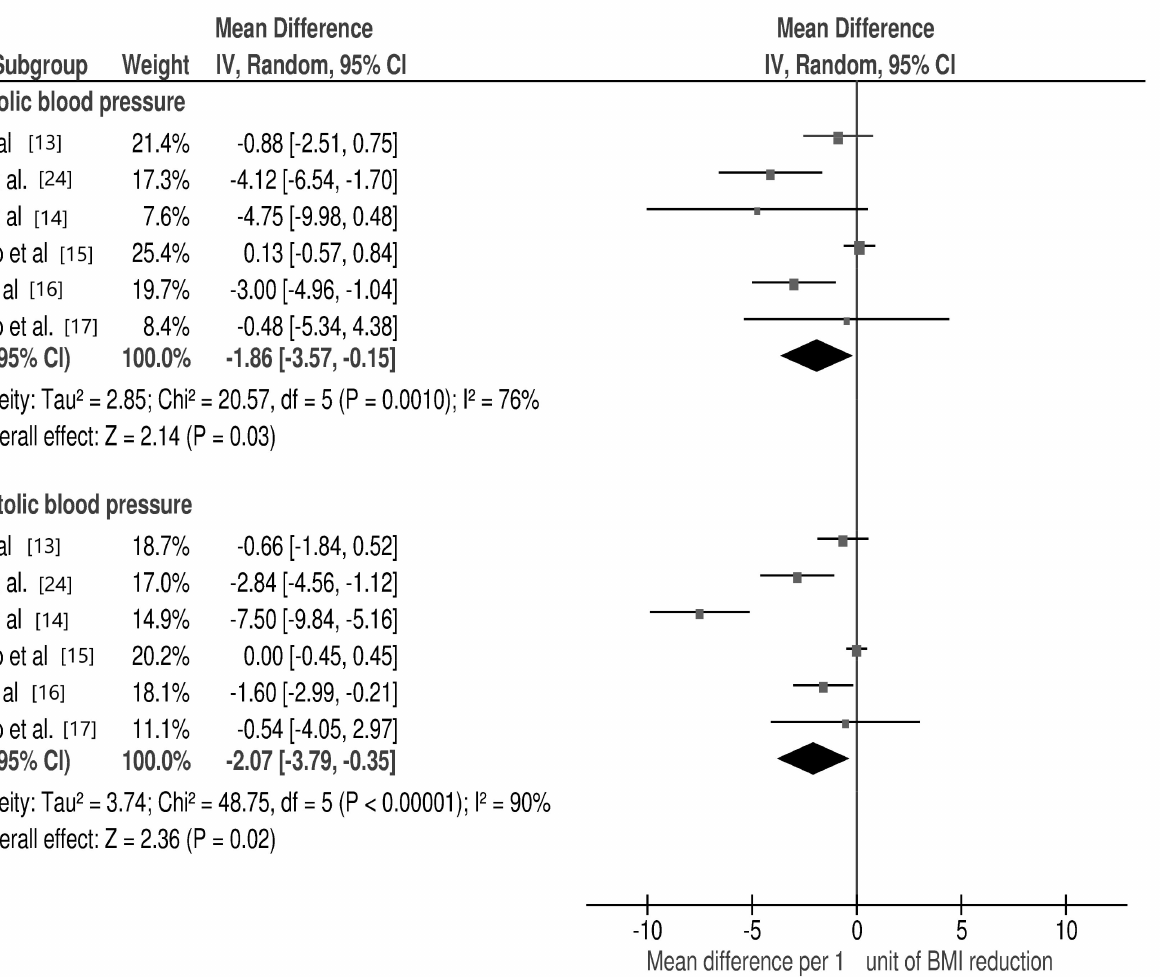
Figure 4. Forest plot for mean cardio-metabolic parameter changes in subgroup analysis: systolic and diastolic blood pressure per 1 unit of body mass index (BMI) reduction in selected